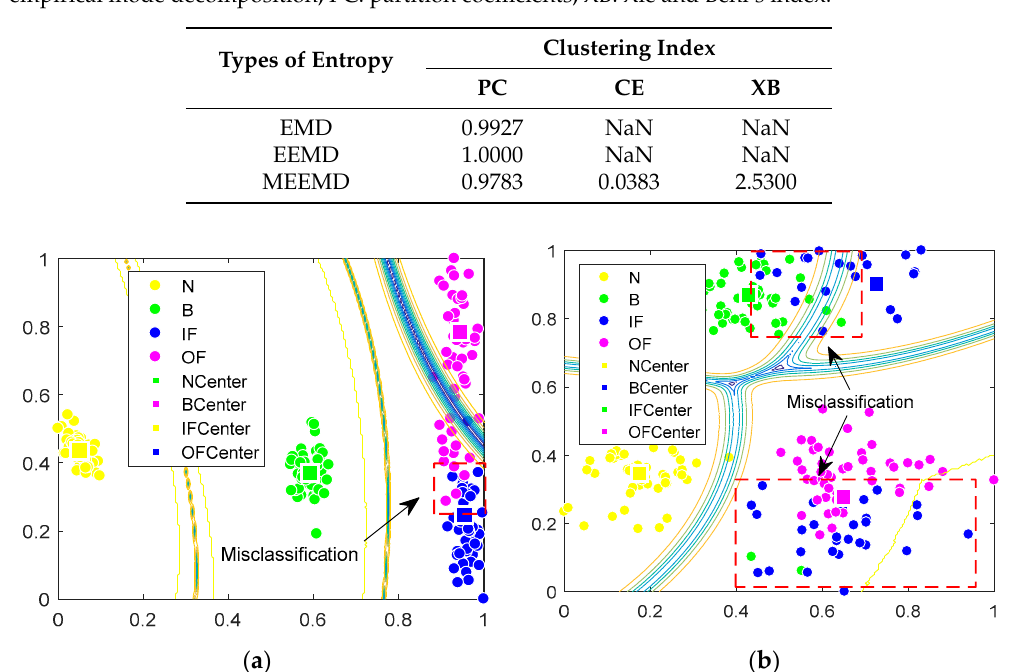
Table 4. GG clustering index using permutation entropy. CE: classification entropy, EMD: empirical mode decomposition, EEMD: ensemble empirical mode decomposition, MEEMD: modified ensemble empirical mode decomposition, PC: partition coefficients, XB: Xie and Beni’s index.